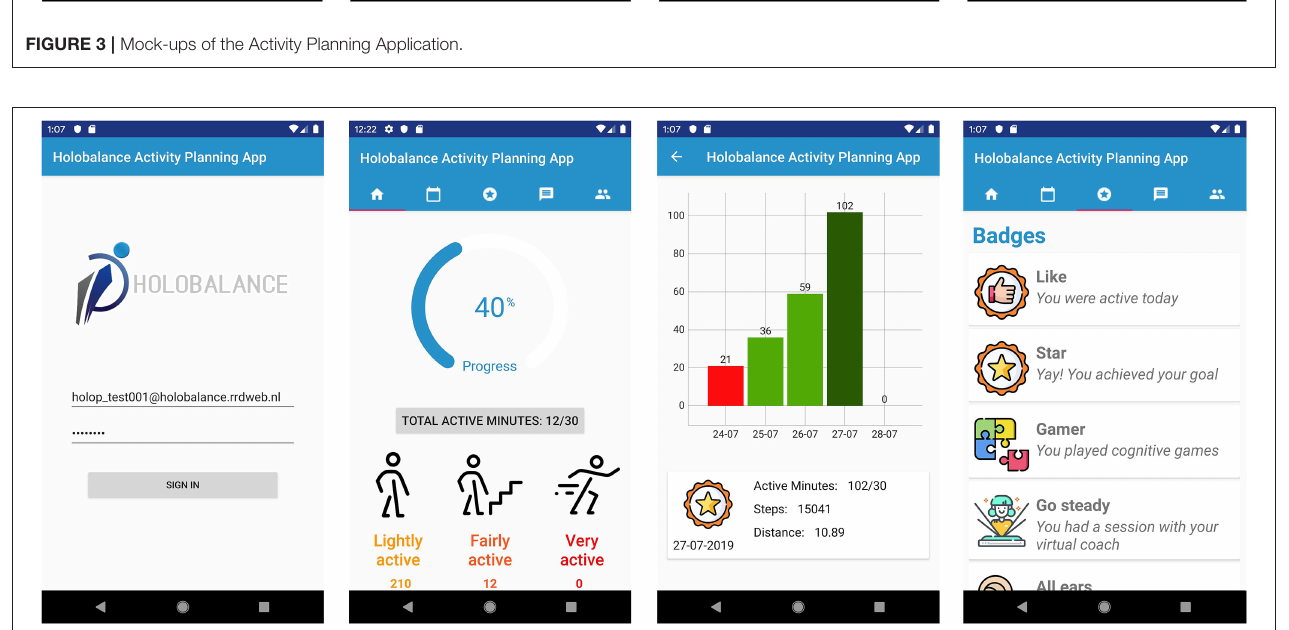
FIGURE 4 | First version of the Activity Planning